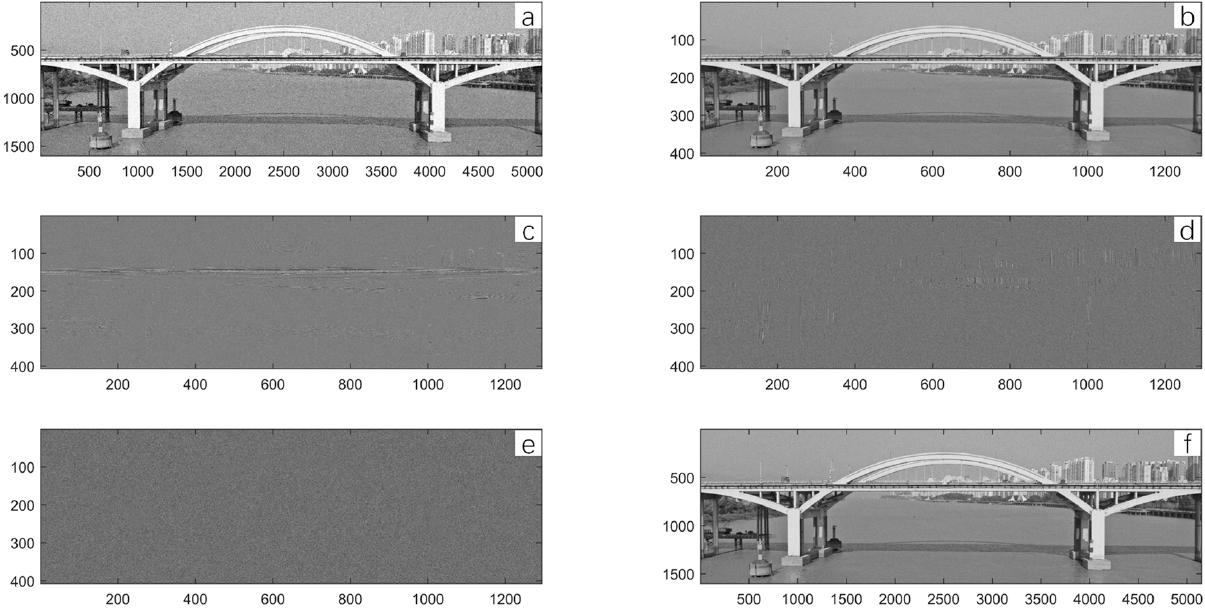
Figure 3. The first level of decomposition: ( a ) noisy image; ( b ) approximation coefficient; ( c ) detail coefficient; ( d ) detail coefficient; ( e ) detail coefficient; ( f ) reconstruction result.